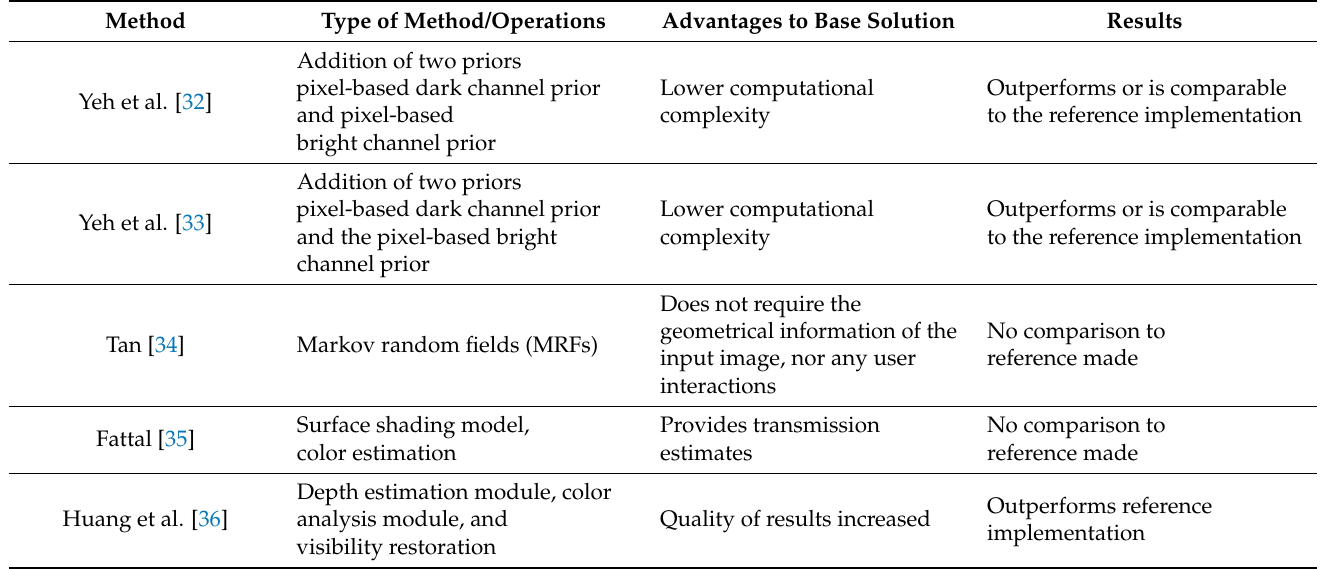
Table 1. Method result